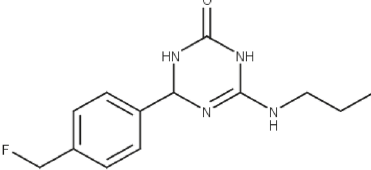
FIGURE 14 - Derivative triazinone that acts simultaneously on the enzymes BACE-1 and GSK-3B.